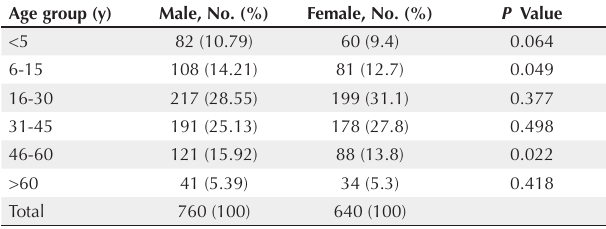
Table 1. Age Group Representation of Population Categorized as Male and